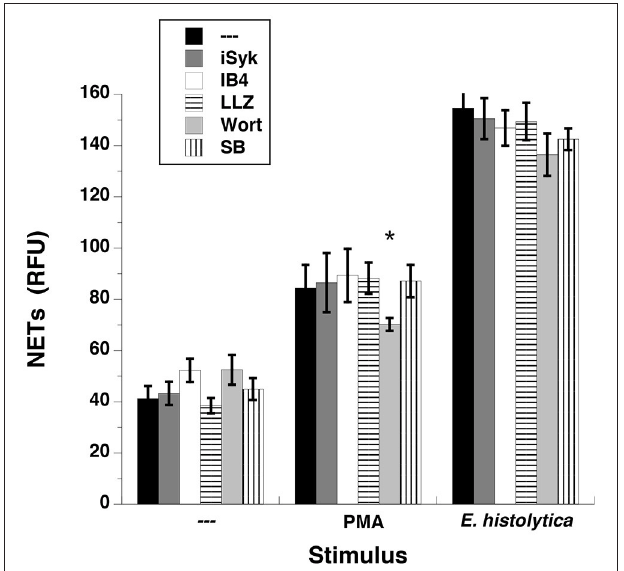
FIGURE 13 | Entamoeba histolytica- induced NET formation is independent on Syk, TAK1, β 2 integrins, PI3K, and p38 MAPK. Human neutrophils were left untreated (—), stimulated with 20 nM phorbol 12-myristate 13-acetate (PMA), or with E. histolytica trophozoites. PMN were previously treated with solvent alone (—) or 1 µ M iSyk, a Syk inhibitor, or 10 µ g/ml of the blocking monoclonal antibody anti- β 2 integrins (IB4), or 10nM LLZ 1640-2 (LLZ), a TAK1 inhibitor, or 50nM Wortmannin (Wort), a PI3K inhibitor, or 200nM SB203580 (SB), a p38 MAPK inhibitor. The relative amount of NETs was estimated from SYTOX ® Green fluorescence in relative fluorescent units (RFU) at 4h after stimulation. Data are mean ± SEM of three experiments. Asterisk denotes a condition that was statistically different from control ( p < 0.05).